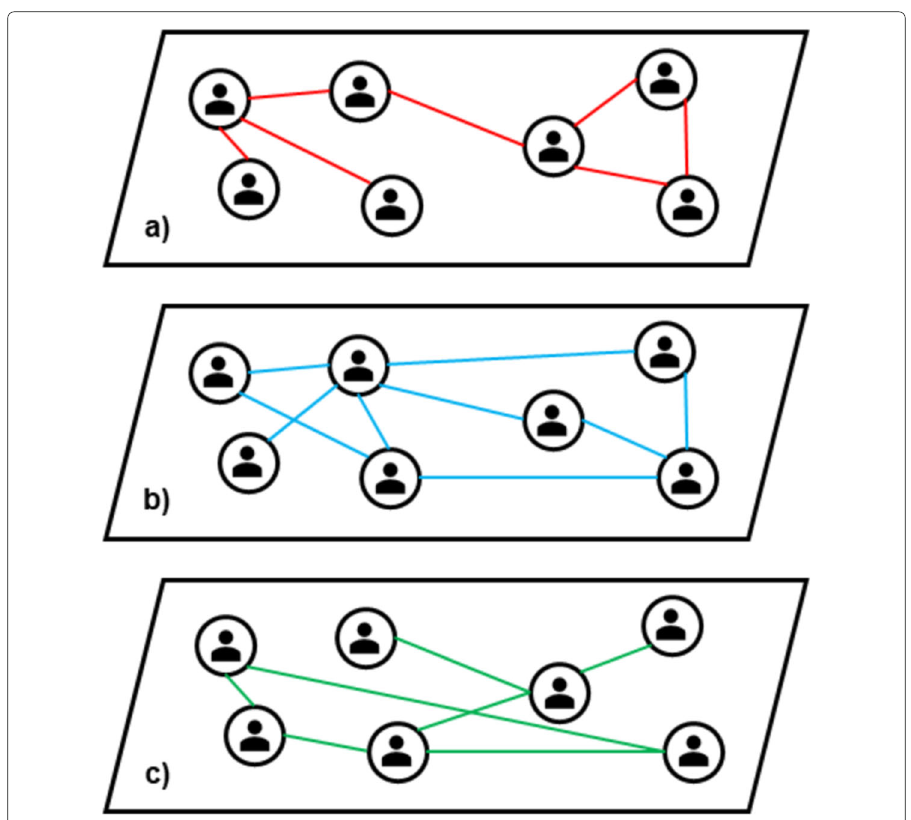
Fig. 1 An example of a multiplex network. Different layers represent different